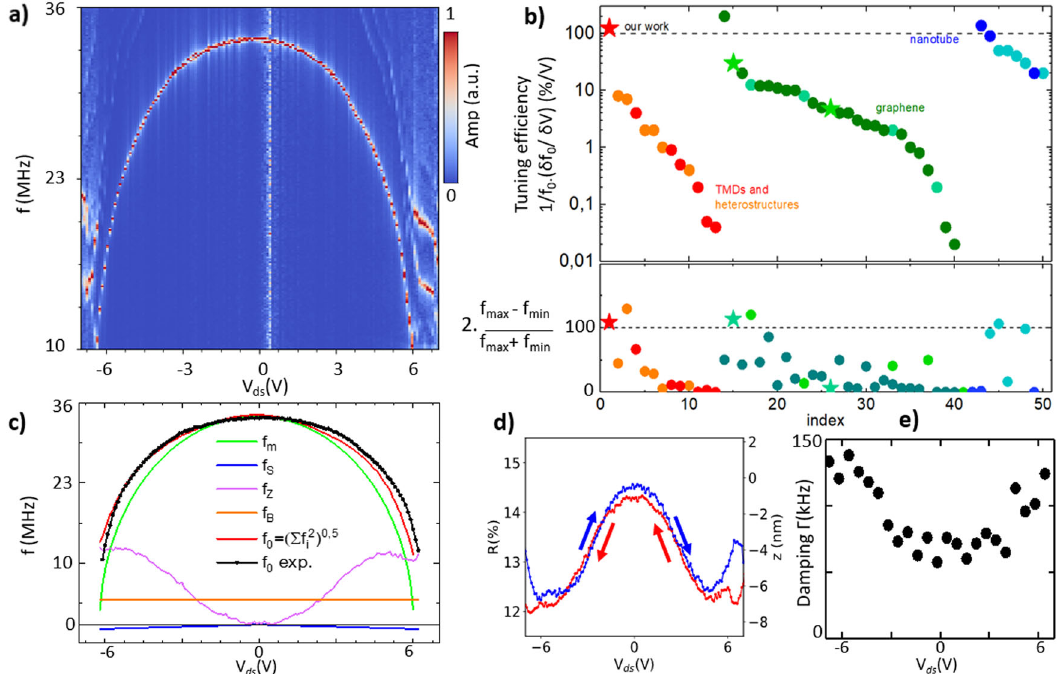
Fig. 2 Joule heating induced a tuning of the vibrations. a Variation of the frequency with respect to V ds ( V g = 1 V). It shows a huge frequency tunability from 34 to 10 MHz for a V ds variation of 7 V. A strong softening of the frequency is observed. b Values of the frequency tuning ef fi ciency Tf V and Tf A for our work (index = 1) and other reference on TMDs and 2D heterostructures. c The experimental mode frequency and all different contributions f m ,f z ,f S ,f B . d Re fl ectivity ( R ) and vertical de fl ection variation ( Δ z) of the sample with respect to V ds ( V g = 1 V). The measurement is done at the middle of membrane. We arbitrarily fi x Δ z = 0 nm at V ds = 0 V (red and blue for back and forth measurement). e The corresponding damping of the resonator Γ = f 0 / Q